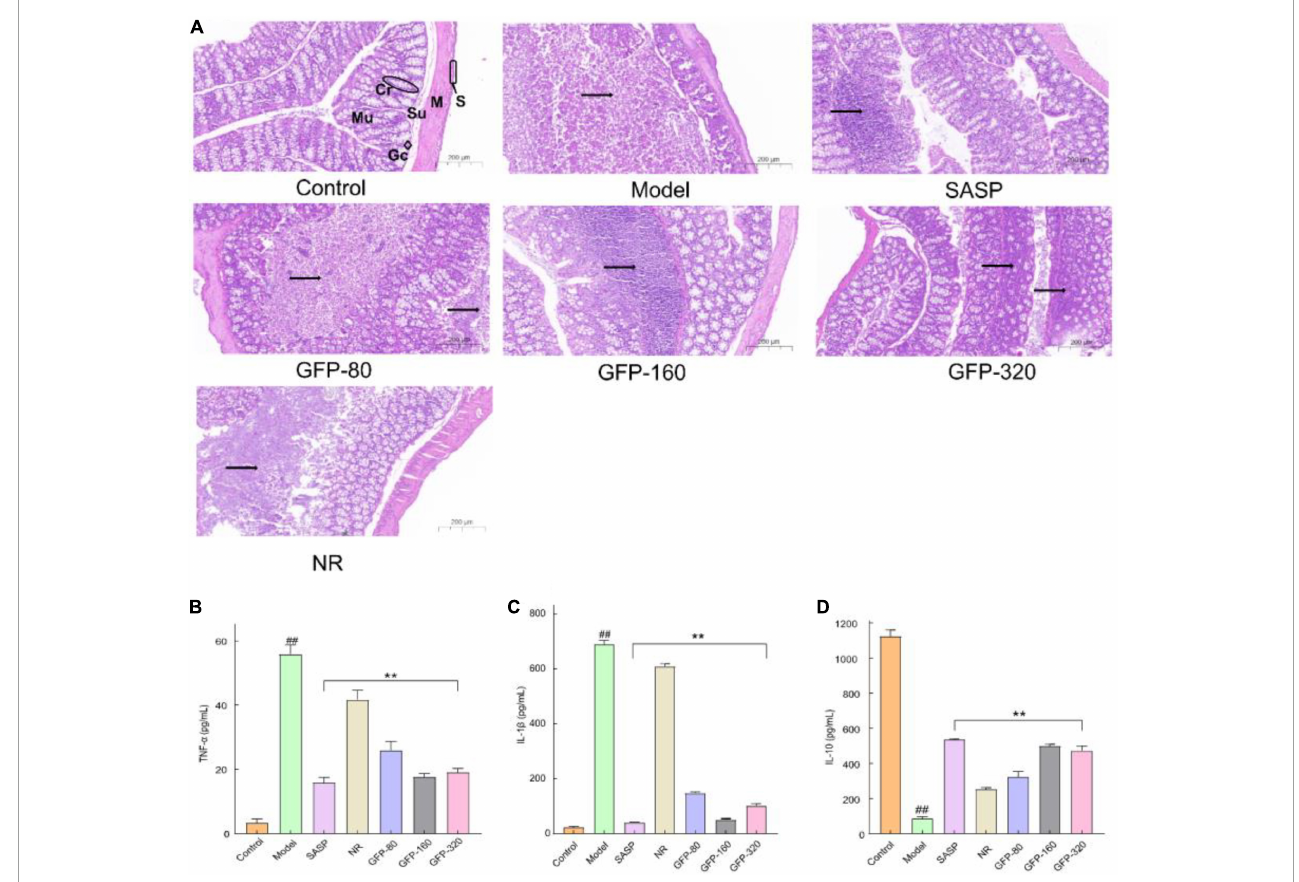
FIGURE7 Results of histological examination and inflammatory factors in each group. (A) Results of histological examination. Mu, mucosa; Su, submucosa; M, muscle; S, serosa; Cr, crypt; Gc, goblet cell; → , inflammation. (B) The concentrations of TNF- α . (C) The concentrations of IL-1 β . (D) The concentrations of IL-10. Each value presents the mean ± SD of three independent experiments. ## Very significant difference compared with the control group ( P < 0.001), **extremely significant difference compared with the model group ( P <